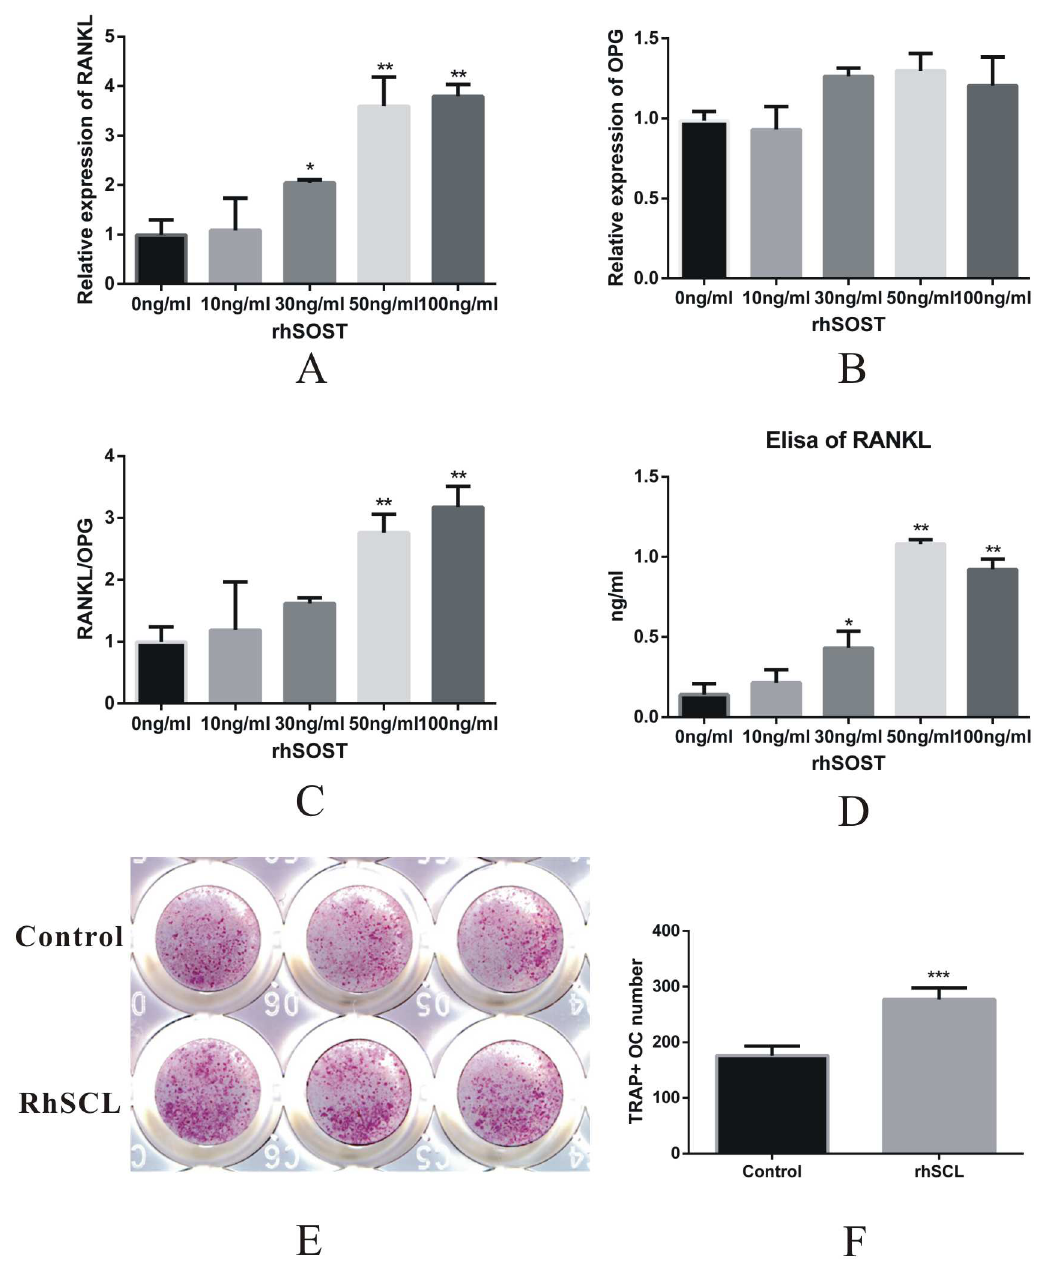
Fig 5. Sclerostin enhanced RANKL expressionand osteoclastic inducible ability of osteocytes. (A) Relative mRNA expressionof RANKL in the MLO-Y4 cells under 0 ng/ml, 10 ng/ml, 30 ng/ml, 50 ng/ml and 100 ng/ml rhSCL interference. The expressionof RANKL was significantly increasedwith 30 ng/ml, 50 ng/ml and 100 ng/ml. * p < 0.05vs 0 ng/ml. ** p < 0.01vs 0 ng/ml. (B) The relativemRNA expressionof OPG in the MLO-Y4 cells under rhSCL interference. No significantchangein the OPG level. (C) The ratio of RANKL/OPG was significantly increasedunder 50 ng/ml and 100 ng/ml rhSCL interference. ** p < 0.01vs 0 ng/ml. (D) The release of RANKL by MLO-Y4 was determined by ELISA under rhSCL interference. ** p < 0.01vs 0 ng/ml. (E) The TRAP stainingof the co-culture of the MLO-Y4 and RAW264.7 cells with or without rhSCL interference.(F) There was a significantly greater number of TRAP-positive cells in the rhSCL group than in the control group. *** p <